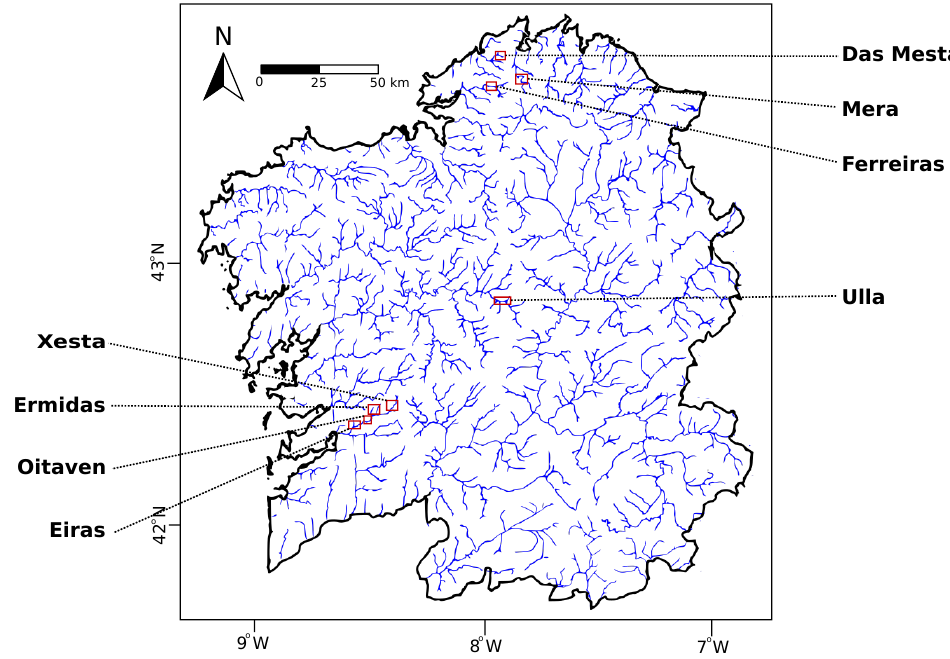
Figure 5. Map of the main rivers of Galicia, Spain, showing the areas studied in this work (data from https://sig.mapama.gob.es/id_tax/ (accessed on 13 May